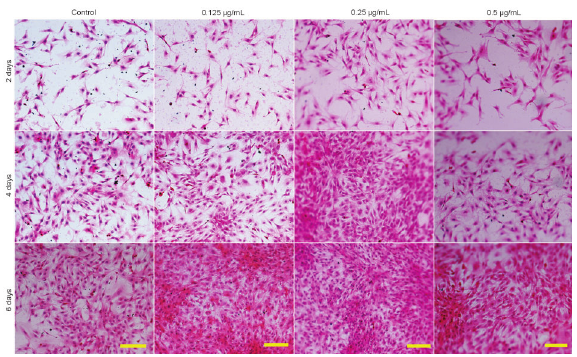
Figure 7. Immunohistochemical staining revealed the presence of type I collagen. Chondrocytes cultured in vitro with 0 (control), 0.125, 0.25, and 0.5 m g/mL JJYMD-C for 2, 4, and 6 days. Scale bar: 100 m